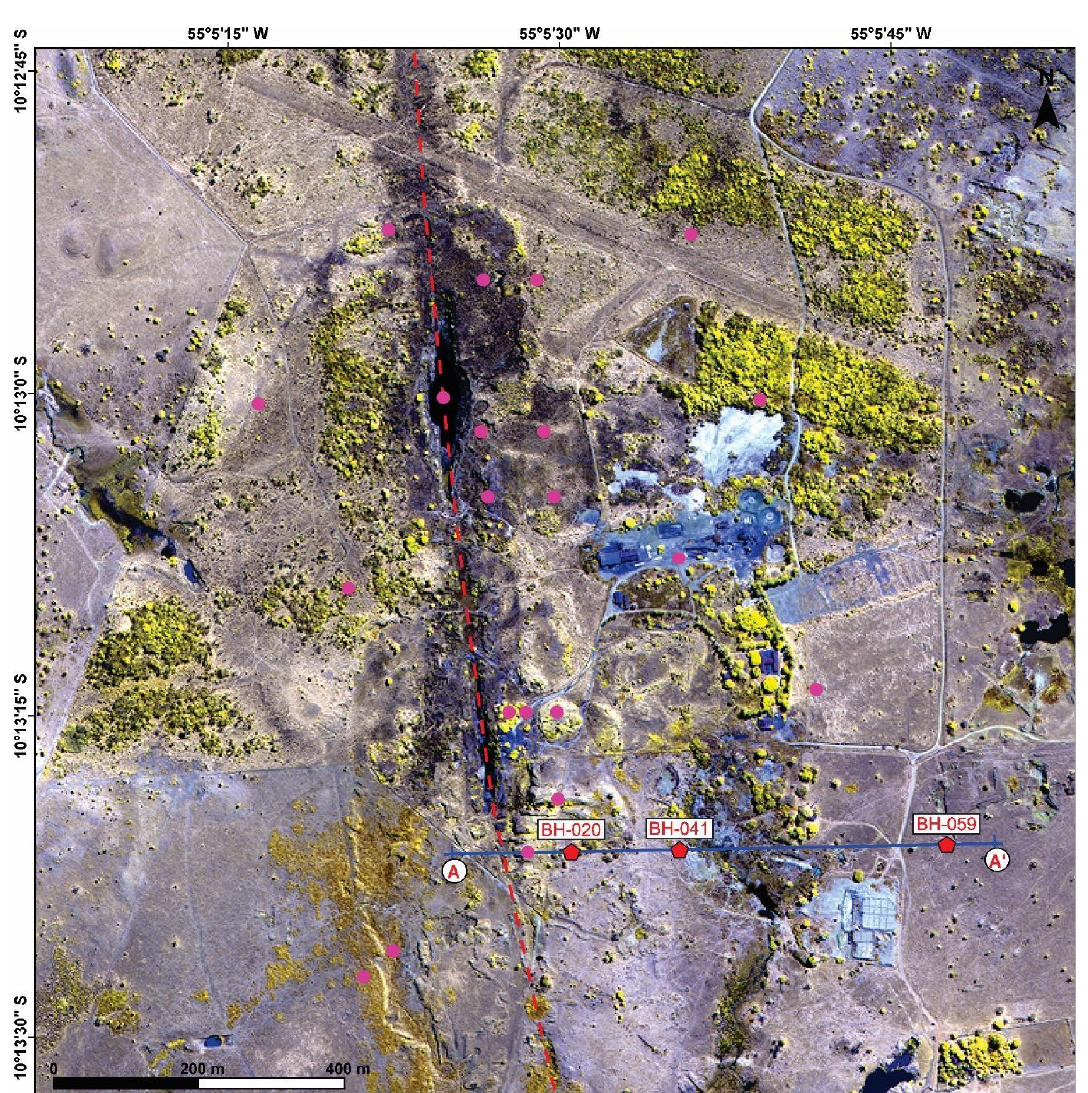
Figure 2. Worldview-2 false color composite (bands 873 in RGB) image of the Paraíba deposit. A dashed red line marks the axis of the ore bodies. Boreholes BH020, BH041, and BH059, which constitute an archetypal cross-section of the deposit (blue line A-A’), are indicated. Pink circles correspond to additional boreholes. Inactive open pits, currently flooded, can also be spotted in the image. Colors in the image can be interpreted as follows: (i) yellow pixels correspond to vegetation; (ii) black to water; (iii) light blue to humid crops; (iv) white to exposed soil; (v) blue to mining